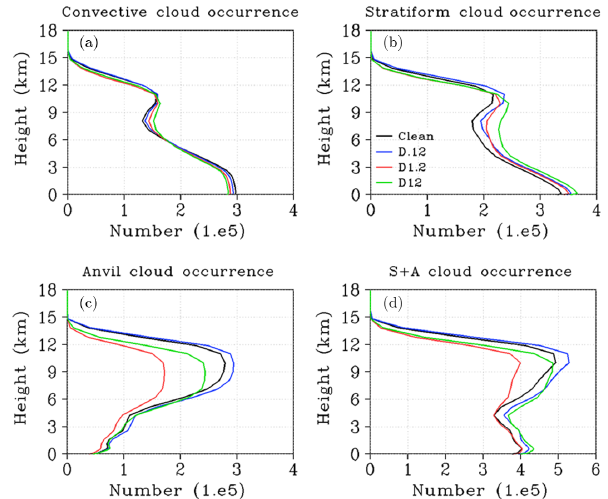
Figure 11. Occurrence frequency of cloudy data points over total simulation time for convective (a) , stratiform (b) , anvil (nonprecip- itating) (c) , and stratiform plus anvil (S + A, d ) clouds. Colors repre- sent Clean (black), D.12 (blue), D1.2 (red), and D12 (green) cases,